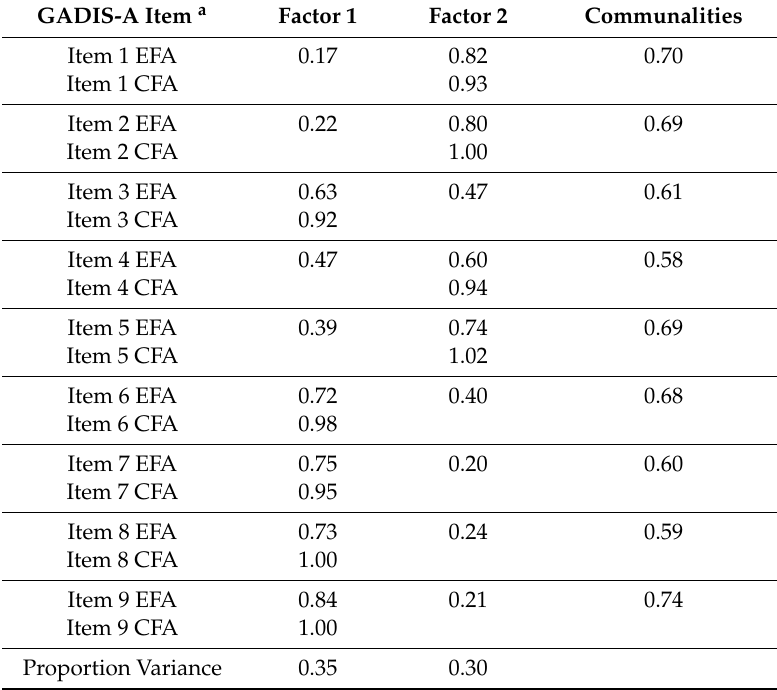
GADIS-A = Gaming Disorder Scale for Adolescents, EFA = Explanatory Factor Analysis, CFA = Confirmatory Factor Analysis. a For the description of the items, refer to Table 1. GADIS-A factor 1 = negative consequences, GADIS-A factor 2 = cognitive-behavioral symptoms, EFA by principal component